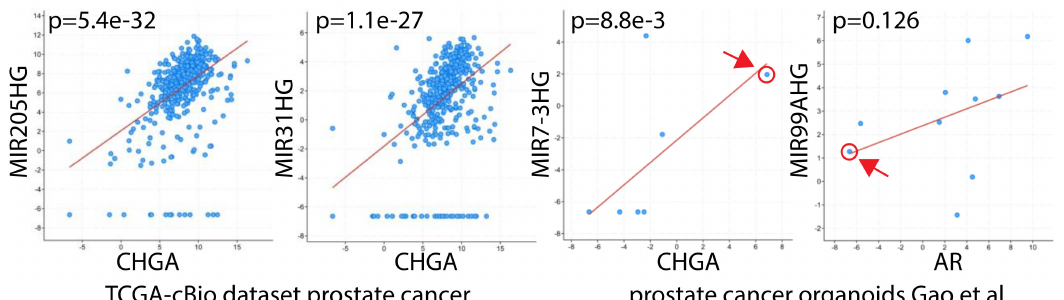
Figure 2. Relationship between neuroendocrine-like di ff erentiation (CHGA + , miR-7 + ) in response to androgen suppression therapy. TCGA data and data from Gao et al. [171] were analyzed using the cBioPortal (https: // www.cbioportal.org) using the co-expression tool [172]. Expression values are in log2. P-values are for the Spearman test. The red circles and arrows depict a prostate cancer organoid with neuroendocrine characteristics (CHGA + , miR-7 + , AR − , miR99a low , plus a lack of cytokeratin expression [171]) derived from a “prostate cancer with treatment-induced neuroendocrine di ff erentiation”. Collectively, these data suggest that true and complete neuroendocrine di ff erentiation is rare in prostate